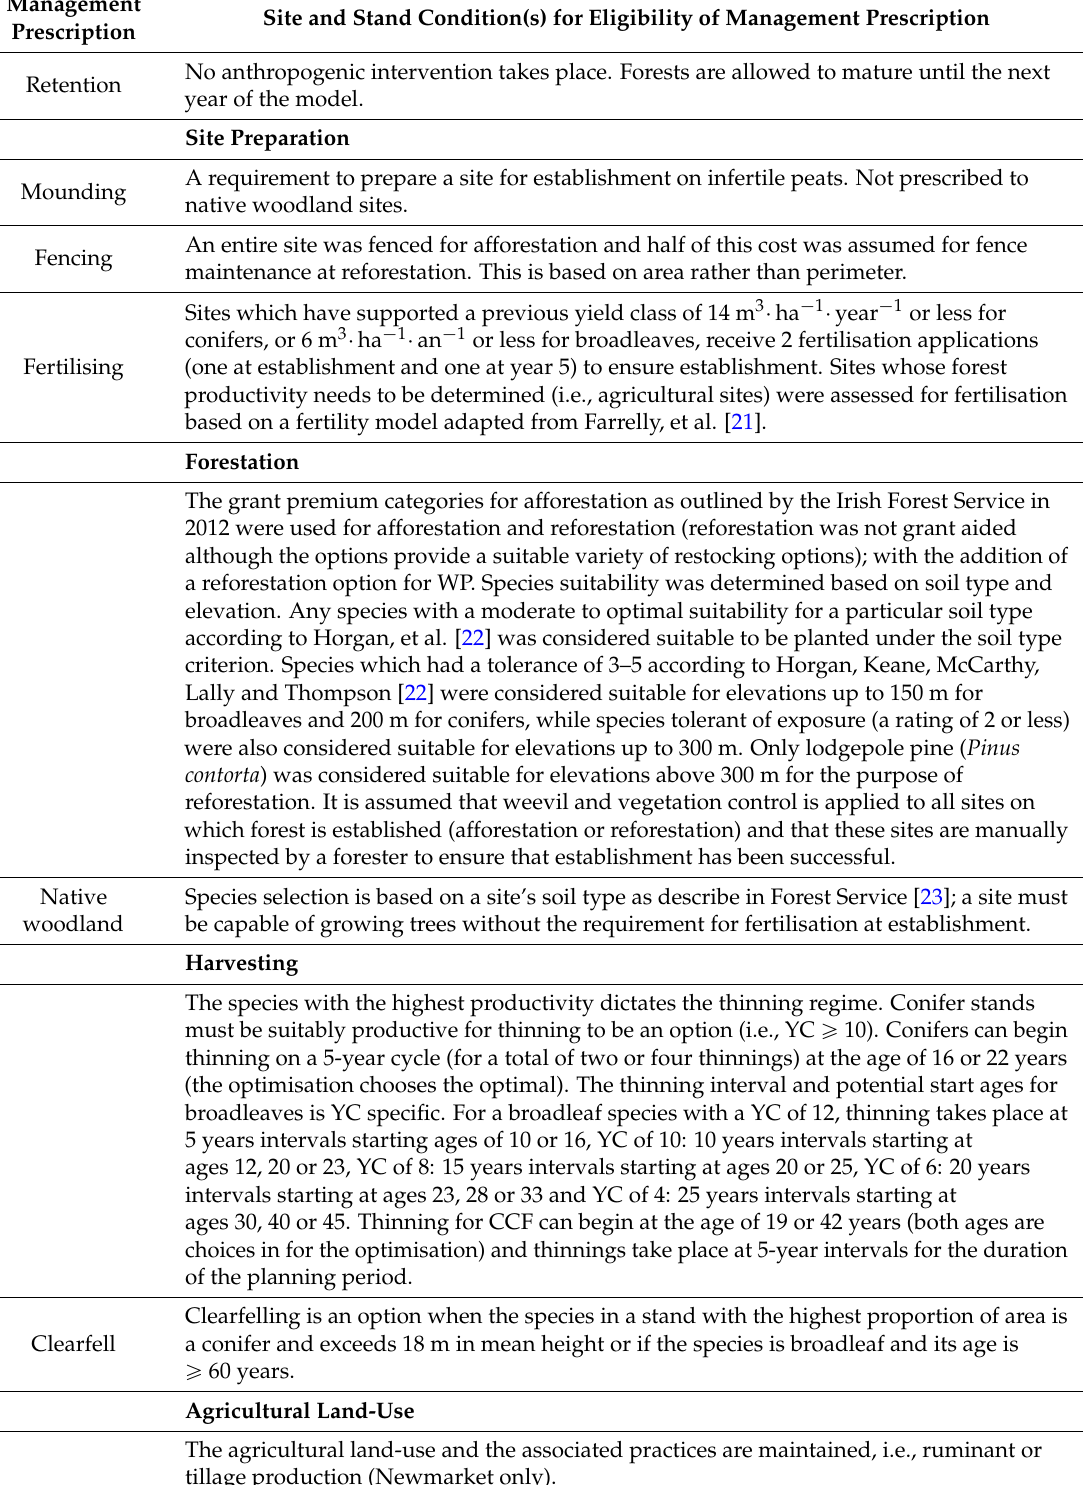
Table 2. Forest management prescriptions available in the